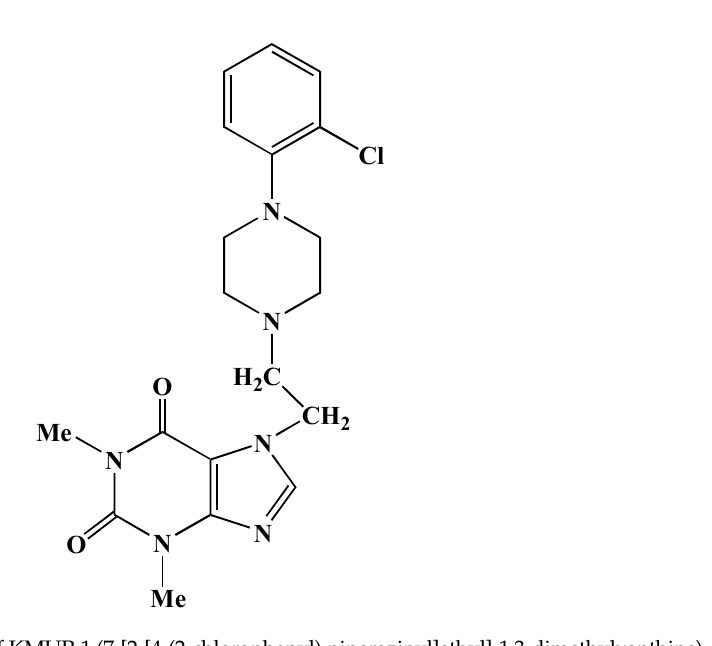
Figure 1. Chemical structure of KMUP-1 (7-[2-[4-(2-chlorophenyl) piperazinyl]ethyl]-1,3-dimethylxanthine).